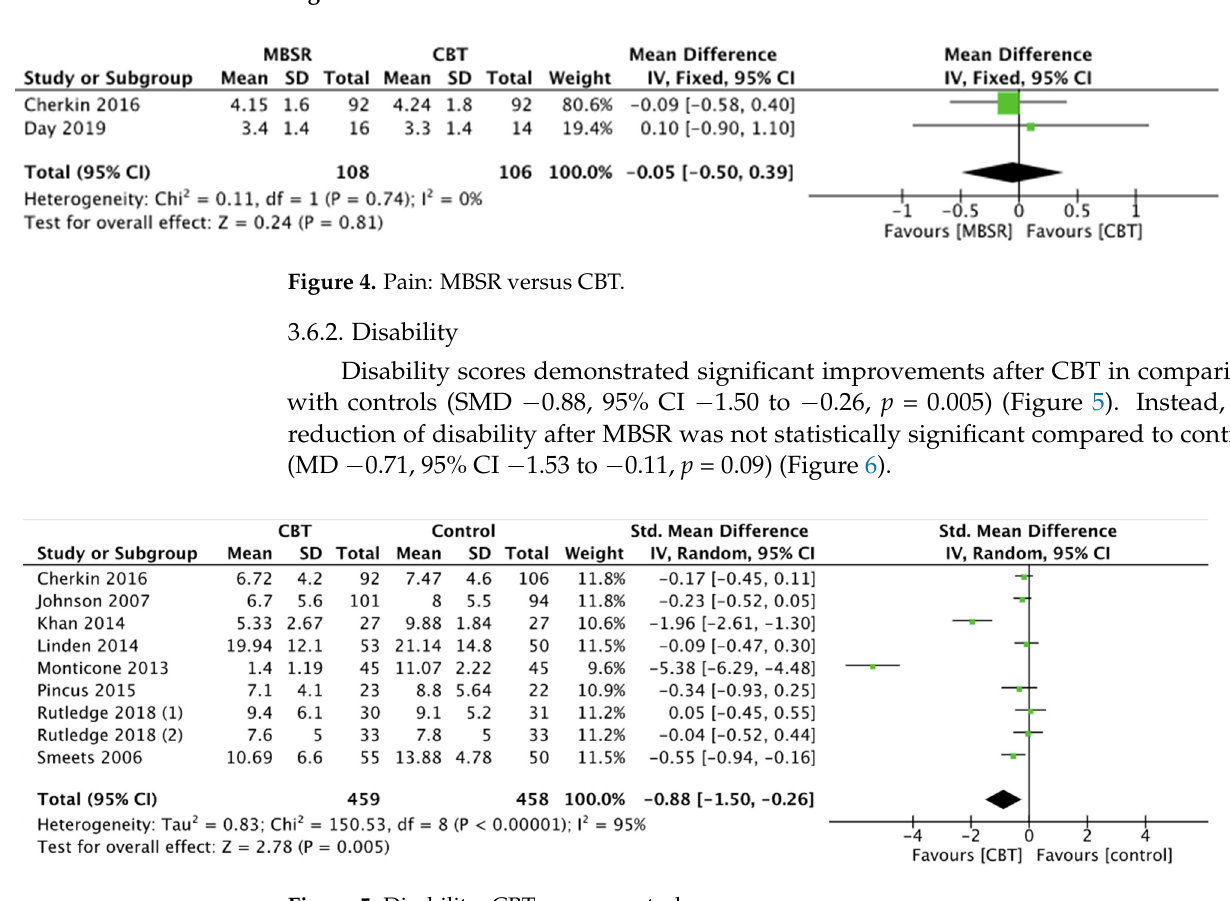
Figure 5. Disability: CBT versus control.